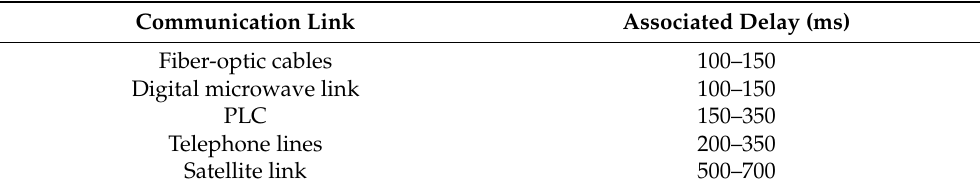
Figure 9. Damping of capacitor voltage, reactive power stator voltage, and electrical torque in k = 75%& v = 7 m/s with FLWADC (ignoring time delay).